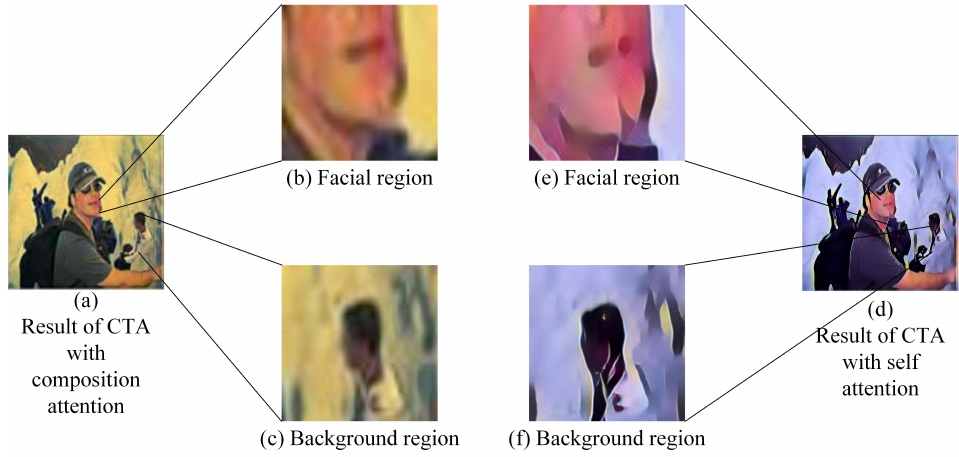
Figure 4. Comparison of the results between CTA with composition attention and CTA with self attention.